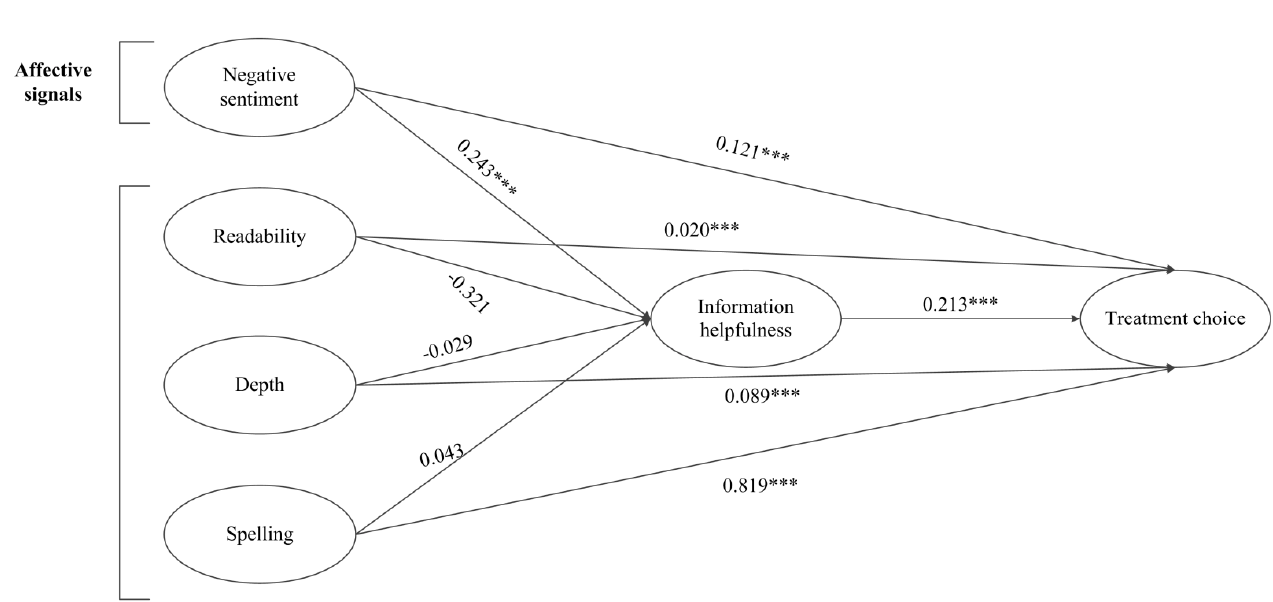
Figure 4. Structural model results. *** p < 0.001.